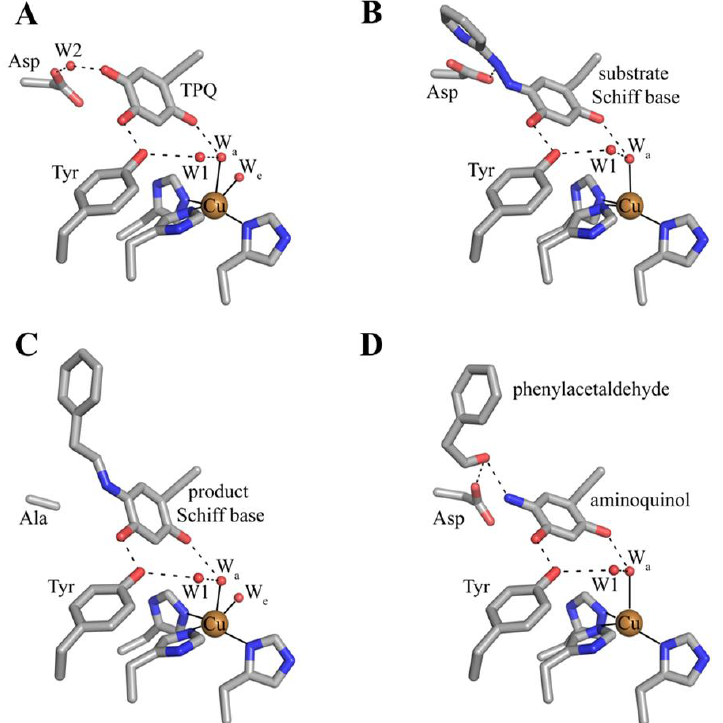
Figure 9. Structurally characterized intermediates formed during the CAO reductive half-reaction. ( A ) native HPAO-1 active site (PDB code 2oov) [64]; ( B ) ECAO containing a substrate Schiff base analog formed with the inhibitor 2-hydrazinopyridine (PDB code 1spu) [86]; ( C ) D298A AGAO containing product Schiff base (PDB code 2cwv) [113]; ( D ) substrate-reduced ECAO containing the aminoquinol (PDB code 1d6u) [88]. Residues are drawn in stick and colored by atom type (carbon, grey). Copper ions are drawn as gold spheres, and water molecules as small red spheres. Dashed lines indicate hydrogen bonds, and solid lines indicate metal-ligand